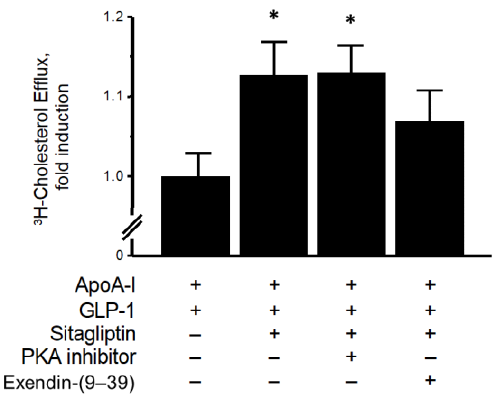
Figure 5. Influence of PKA inhibitor and exendin-(9–39) (150 nmol/L) on elevation of apoA1- mediated cholesterol efflux due to sitagliptin (1 µ mol/L) in the presence of 10 nmol/L GLP-1. Values represent mean ± SD. * p < 0.01 vs. apoA1 + GLP-1. Each group, n = 5 – 6.